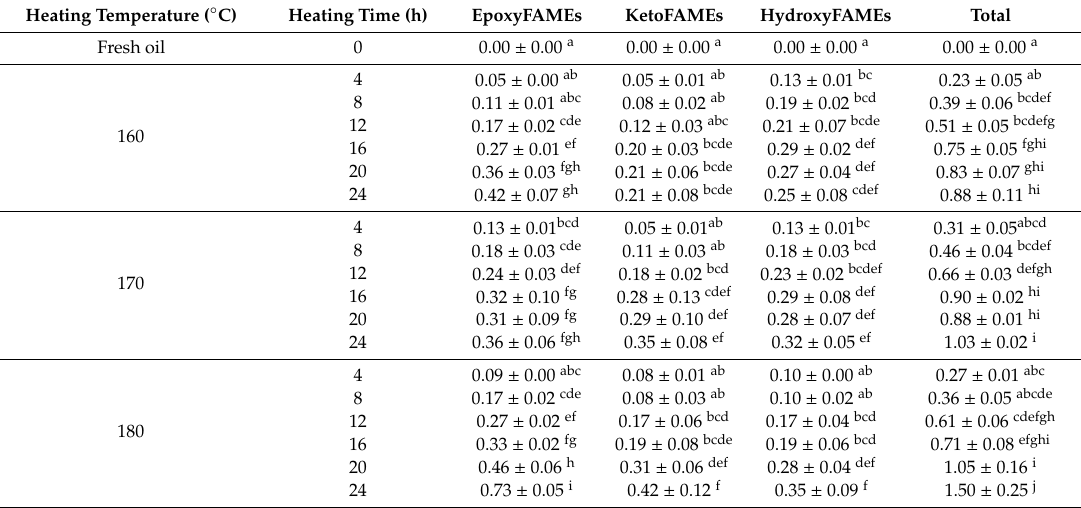
Table 1. Epoxy fatty acid methyl esters (FAMEs), ketoFAMEs and hydroxyFAMEs (g / 100g) in palm olein heated at di ff erent temperatures for di ff erent times. Heating Temperature ( ◦